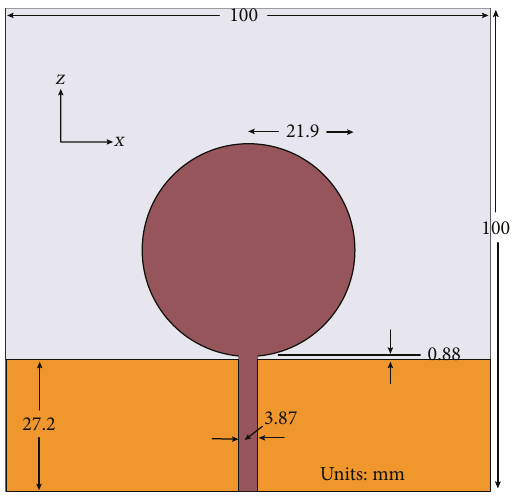
Figure 1: Conventional circular monopole with